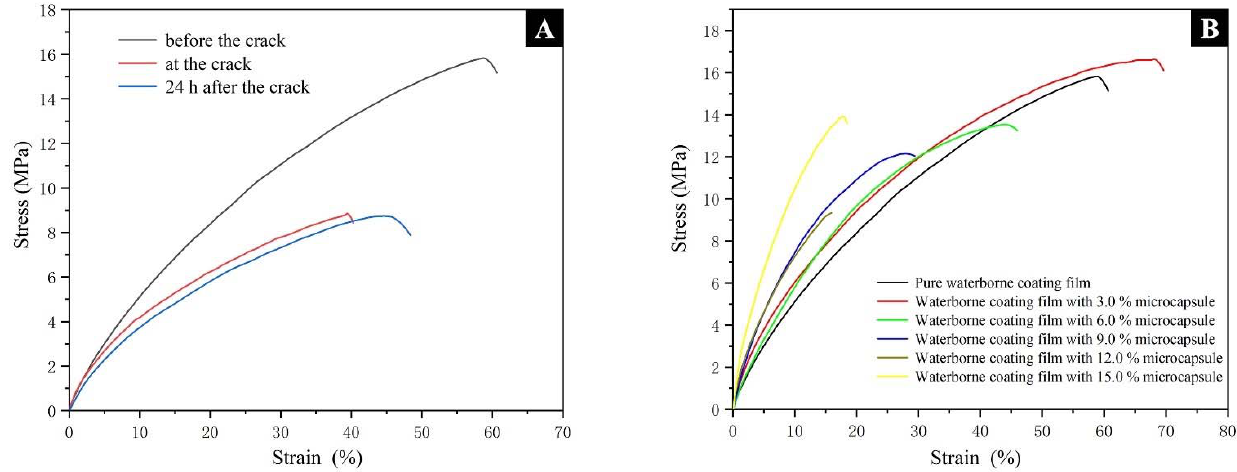
Figure 11. Stress–strain curves: ( A ) the pure waterborne coating before, at, and 24 h after the cracking; ( B ) waterborne coating containing microcapsules with different mass fractions.